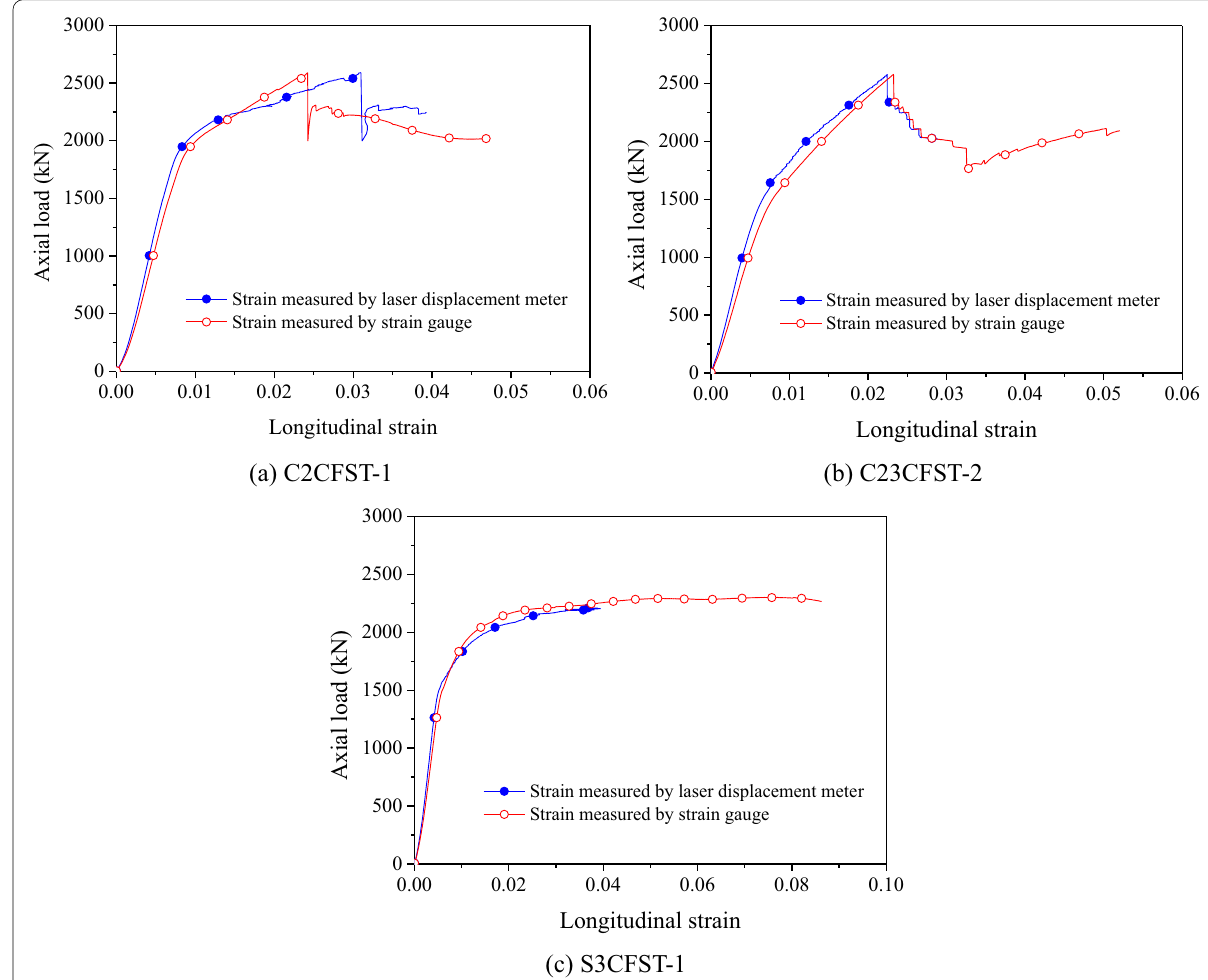
Fig. 13 Axial load–strain curves measured by a laser displacement